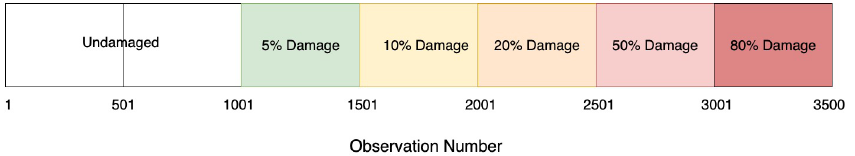
Figure 5. Development of damage with observation number. Each observation represents a set of polluted accelerograms.